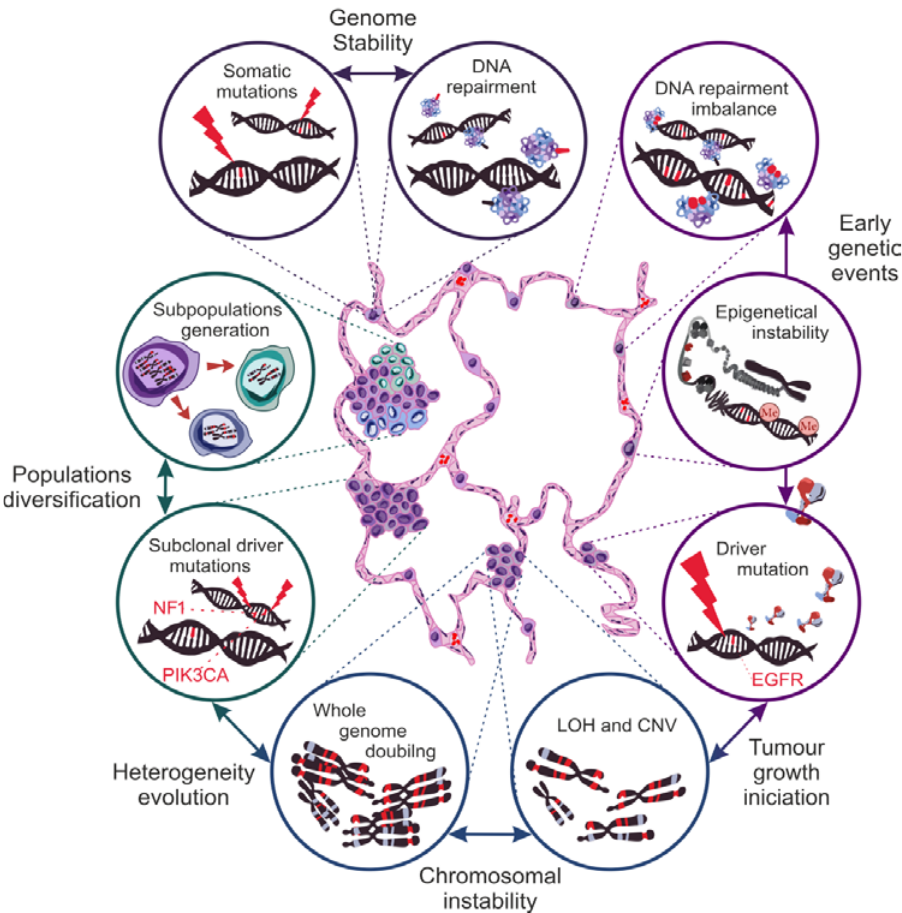
Figure 3. Genetic basis of neoplastic transformation of lung cells and heterogeneity of NSCLC (non-small cell lung cancer). In normal lung tissue, the cell’s genome is kept in balance between mutation occurrence and repair. When endogenous or exogenous factors disrupt this balance, genetic instability occurs, which initiates the pre-initiation phase. During this time, the increasing instability of epigenetic control and the occurrence of new mutations change the activity of the molecular mech- anisms. For neoplastic transformation of the cell, occurring changes need to accumulate and cause defects at the chromosome level (initiation phase). Afterward, the whole genome doubling of clonal cells leads to the development of separate populations with different genotypes. Carcinogenesis enters the progression phase, which results from the formation of cells with increased proliferation and invasiveness, triggering the metastasis formation.